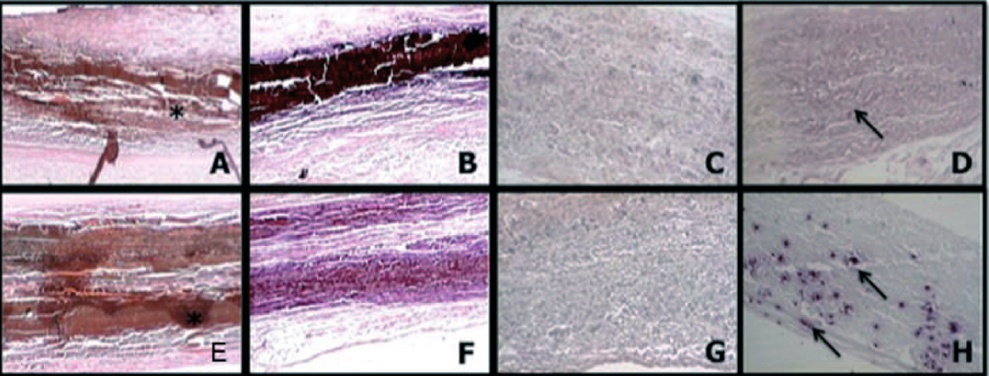
Fig. 3 - Amostras de pericárdio bovino coradas em alizarina- red pH4,2. A - GDA 45 dias; B – GDA-GL 45 dias; C- D-GDA 45 dias; D –D-GDA-GL 45 dias; E - GDA 90 dias; F – GDA-GL 90 dias; G – D-GDA 90 dias; H